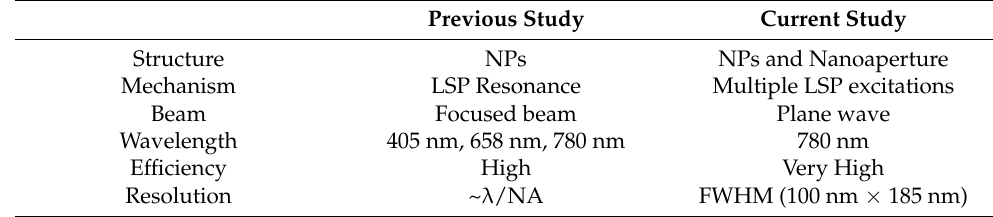
Figure 1. Schematic diagram of optical high power transmission into the Au NPs array deposited media with a ridge-type nanoaperture. Table 1. Previous study and current study.